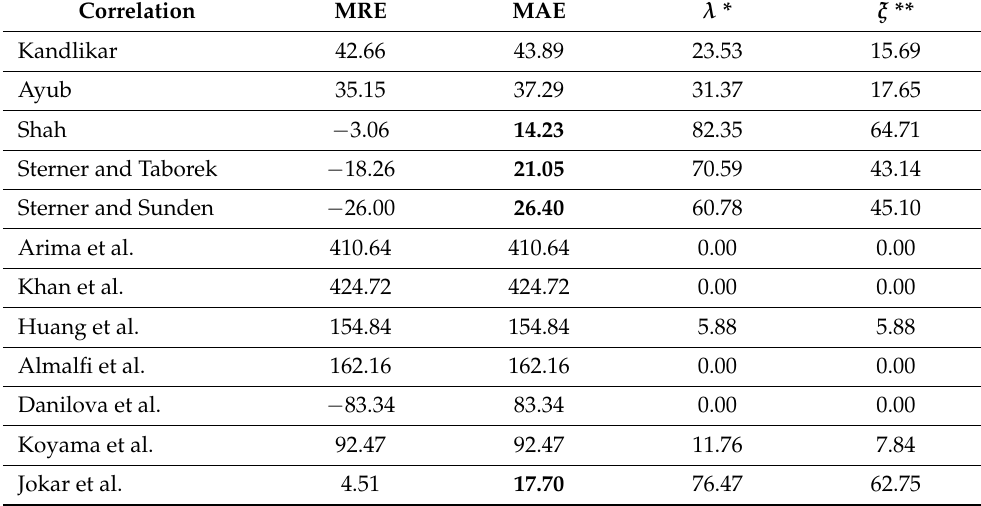
Table 5. Statistic comparison between experimental results and